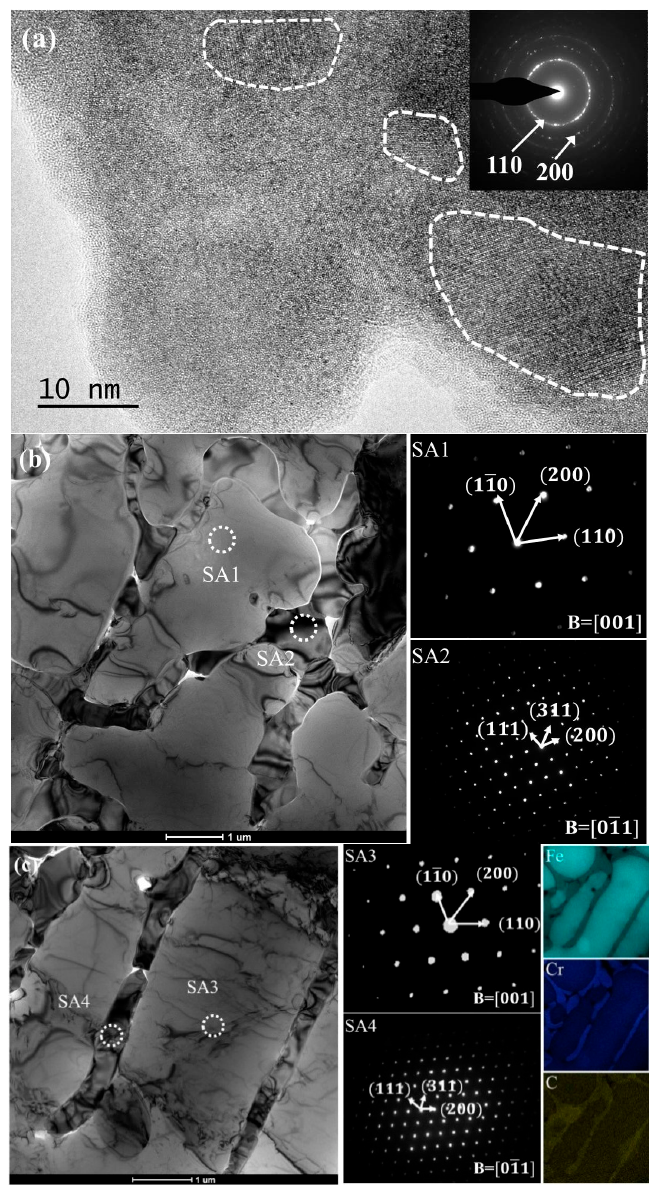
Figure 3. ( a ) High ‐ resolution transmission electron microscopy (HRTEM) micrograph and selected area electron diffraction (SAED) of Sample A; ( b ) TEM image and SAED patterns of Sample D, the SAED patterns of the circled region SA1 and SA2; ( c ) TEM image, SAED patterns and energy dispersive spectrometer (EDS) mapping of Sample E, the SAED patterns of the circled region SA3 and